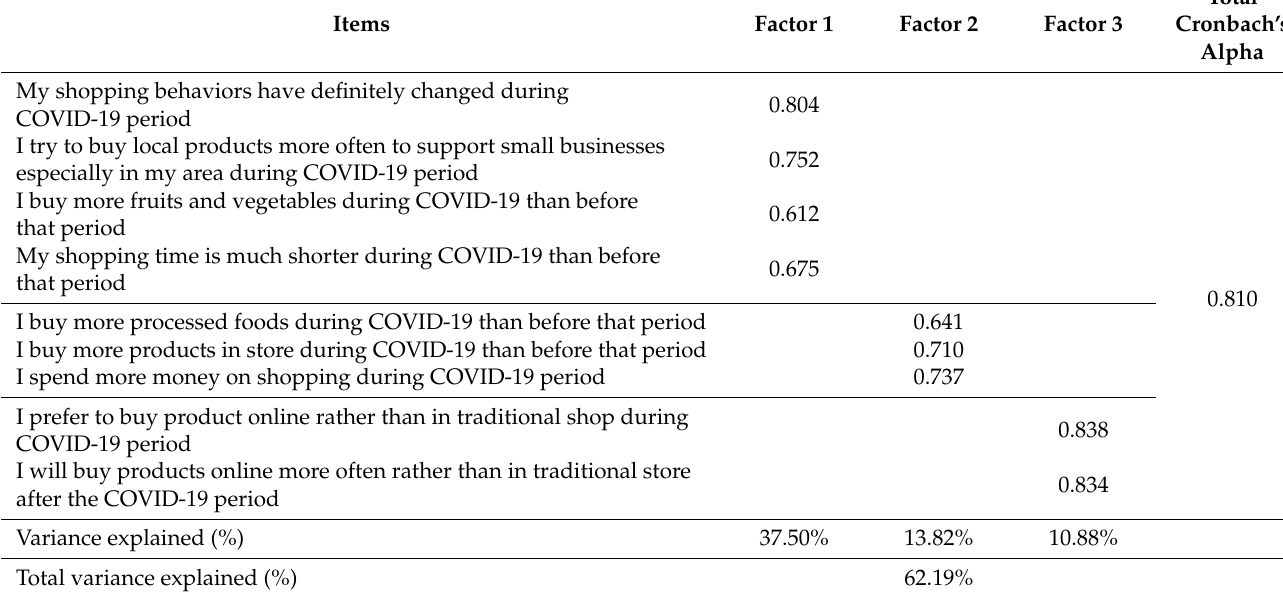
Table 5. The results of EFA: European